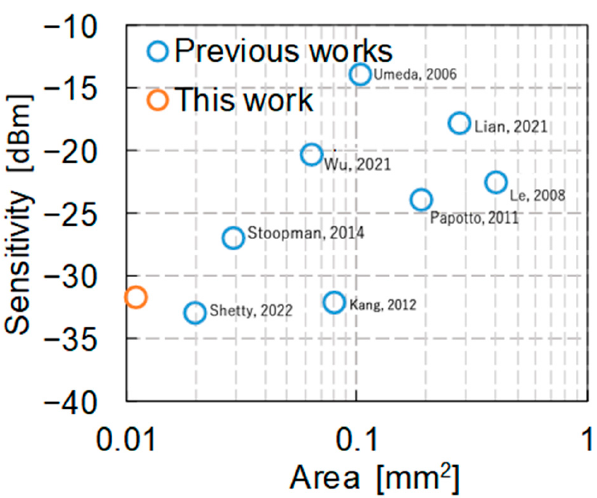
Figure 17. Comparison of area and sensitivity in this work and previous works